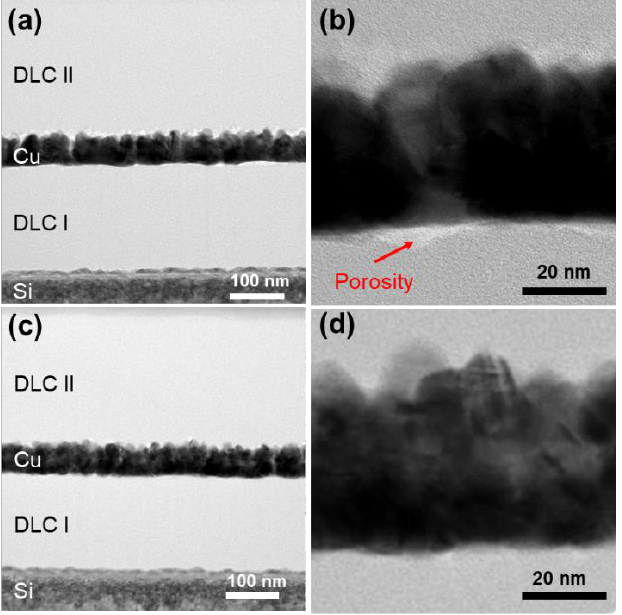
Figure 2. TEM ( a ) overview and ( b ) close-up view images of DLC/Cu (300)/DLC with heat treatment. TEM ( c ) overview and ( d ) close-up view images of DLC/Cu (300)/DLC without heat treatment. Figure 3 presents the TEM images of the samples in groups B and C i.e., DLC/Cu (50)/DLC and DLC/Cu (25)/DLC/Cu (25)/DLC, respectively. The sample interfaces presented different thicknesses, and the images in Figure 3a,c confirmed the 3-layer and 5-layer structures, respectively. The samples without heat treatment did not exhibit any porosity, unlike that for the samples subjected to heat treatment.